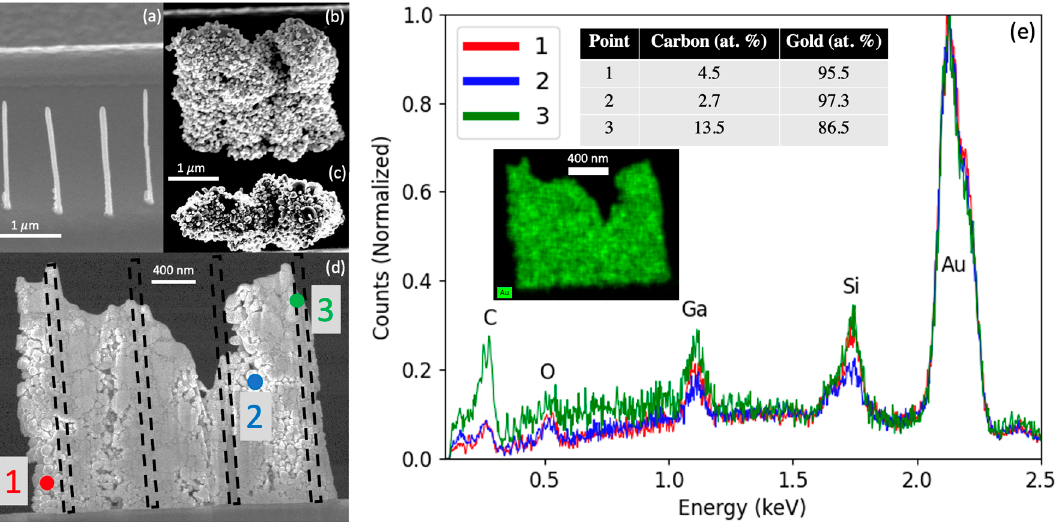
Figure 3. ( a ) A 52 ° tilted SEM image of the as-deposited PtC x nanopillars. ( b ) A 52 ° tilted SEM image of the nanopillars after gold selected area deposition. ( c ) Top-down SEM image of ( b ). ( d ) The Ga + FIB thinned lamella and EDS measurement locations; the black dashed boxes estimate the positions of the original FEBID nanopillars. ( e ) The corresponding EDS spectra, taken at 5 keV 205 pA. The inset in ( e ) is the Au EDS map of the image in ( d